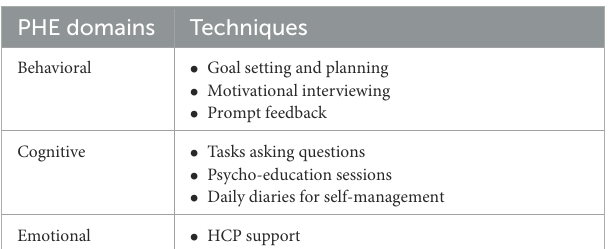
TABLE 3 Techniques considered to promote PHE in the intervention to support hypertension